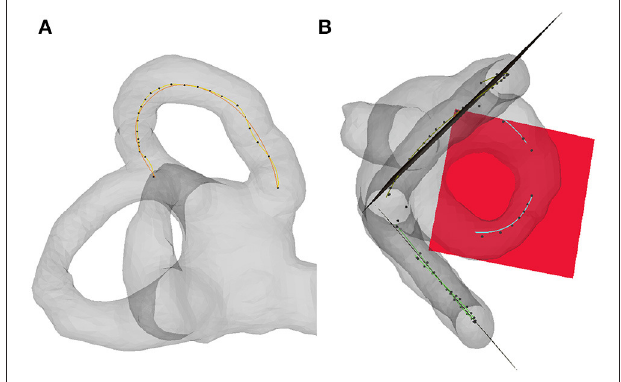
FIGURE 3 | Semicircular canal plane fitting. (A) Fitting spline curve of the semicircular canal centerline (B) Fitting the plane of the semicircular canal according to the spline curve.